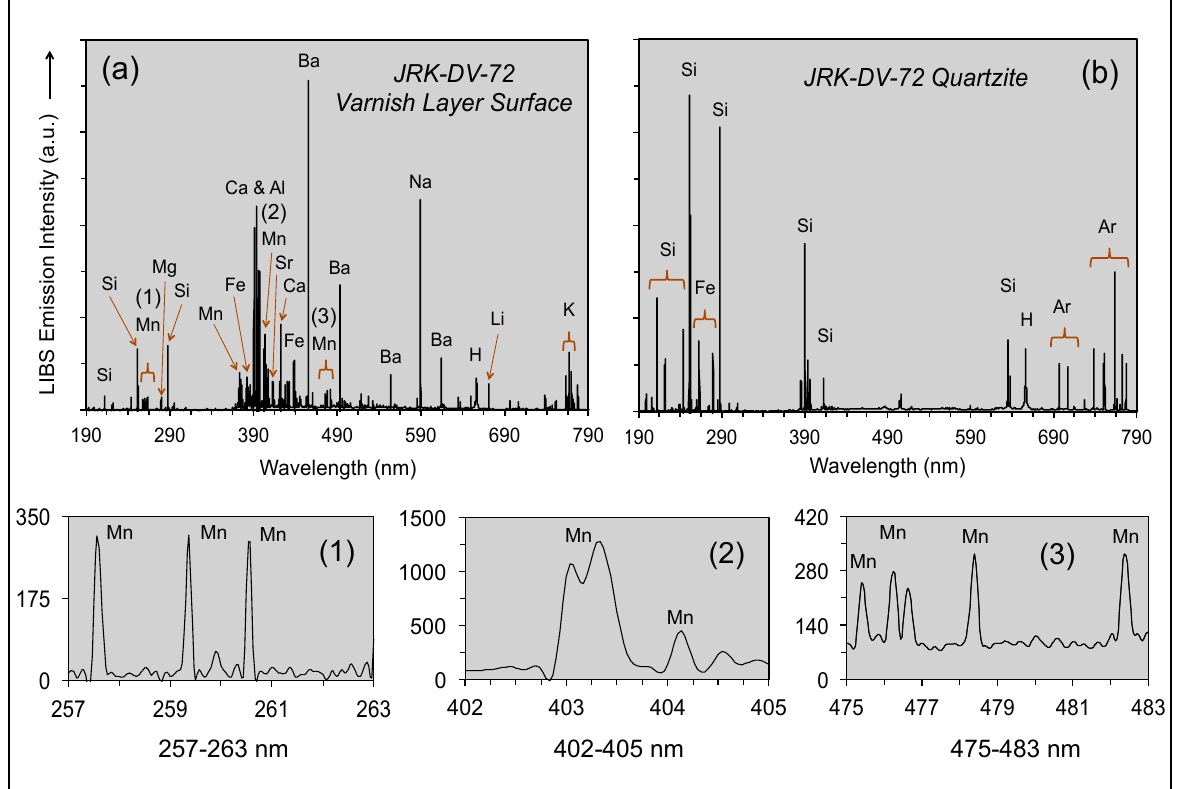
Figure 5. LIBS spectra acquired in the laboratory for ( a ) the varnish layer on the top surface of sample JRK-DV-72 and ( b ) its quartzite substrate.